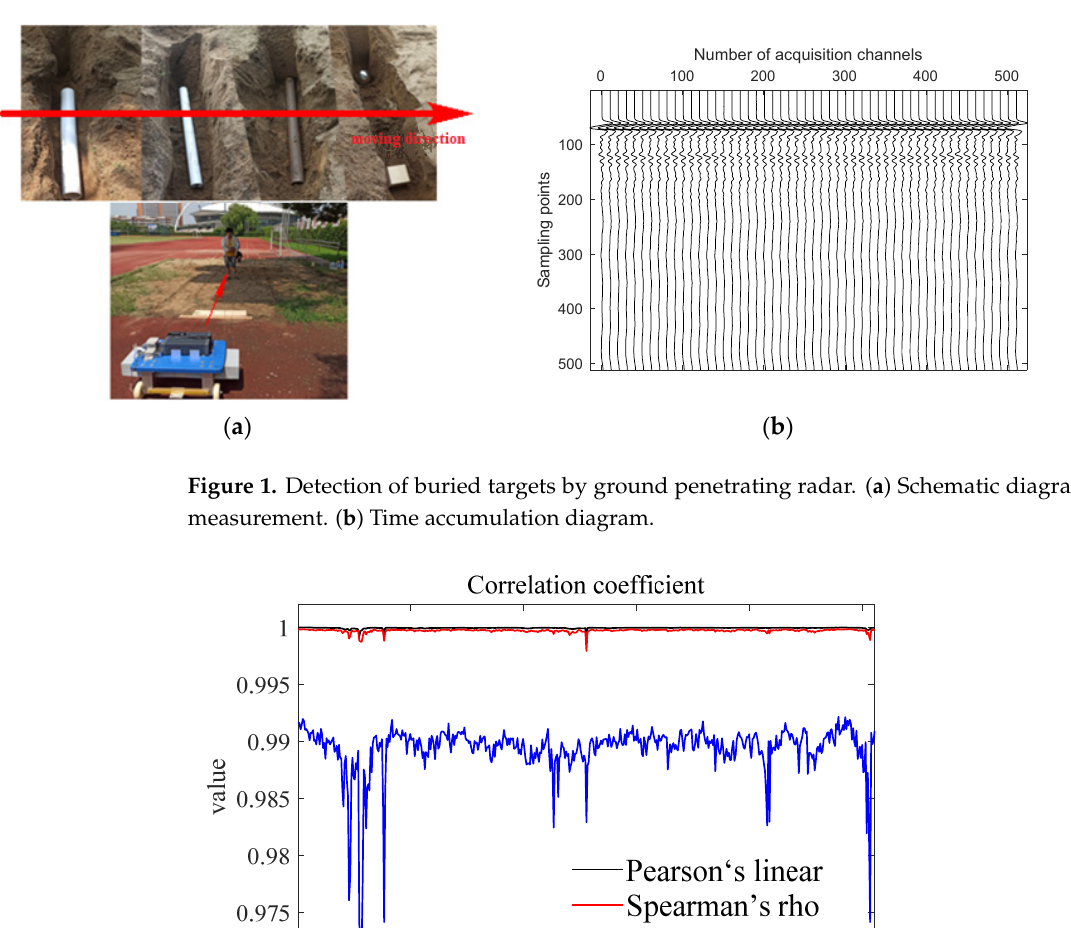
Figure 1. Detection of buried targets by ground penetrating radar. ( a ) Schematic diagram of GPR measurement. ( b ) Time accumulation diagram.